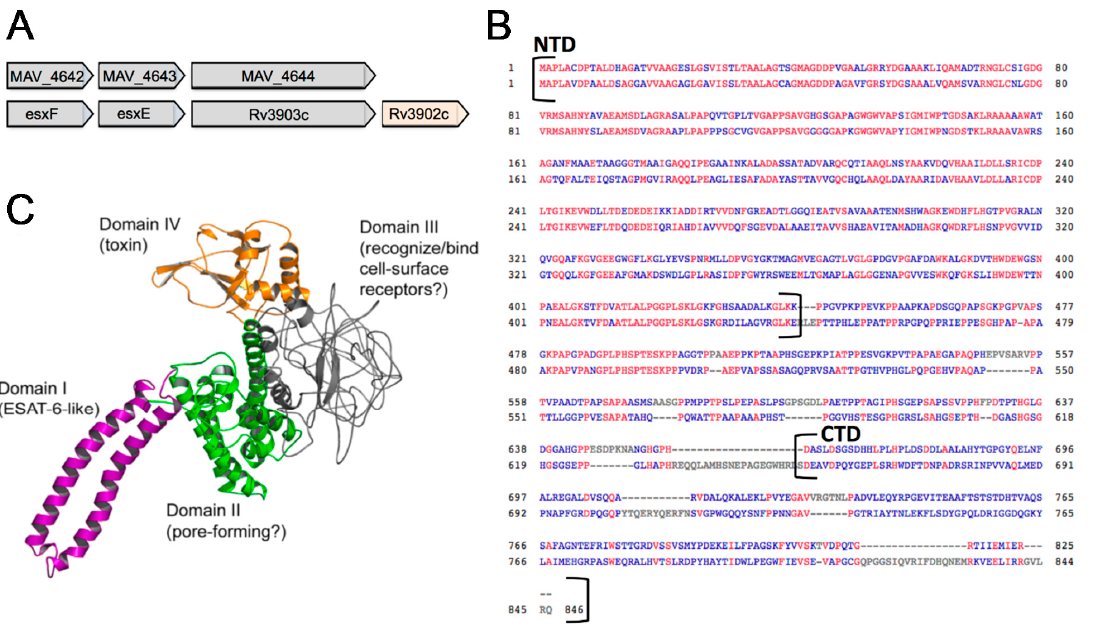
Figure 4. ( A ) Chromosome region of MAV_4644 operon in MAH and corresponding location in M. tuberculosis. ( B ) MAV_4644 and Rv3903c protein alignment. The N-terminal domain (NTD) has 100% query coverage with an E-value of 1E-166 and 73% GC content. CTD has no significant alignment with 52% GC content of gene in MAH and 68% in M. tuberculosis. ( C ) The I-Tasser predictive model of MAV_4644 showing four.